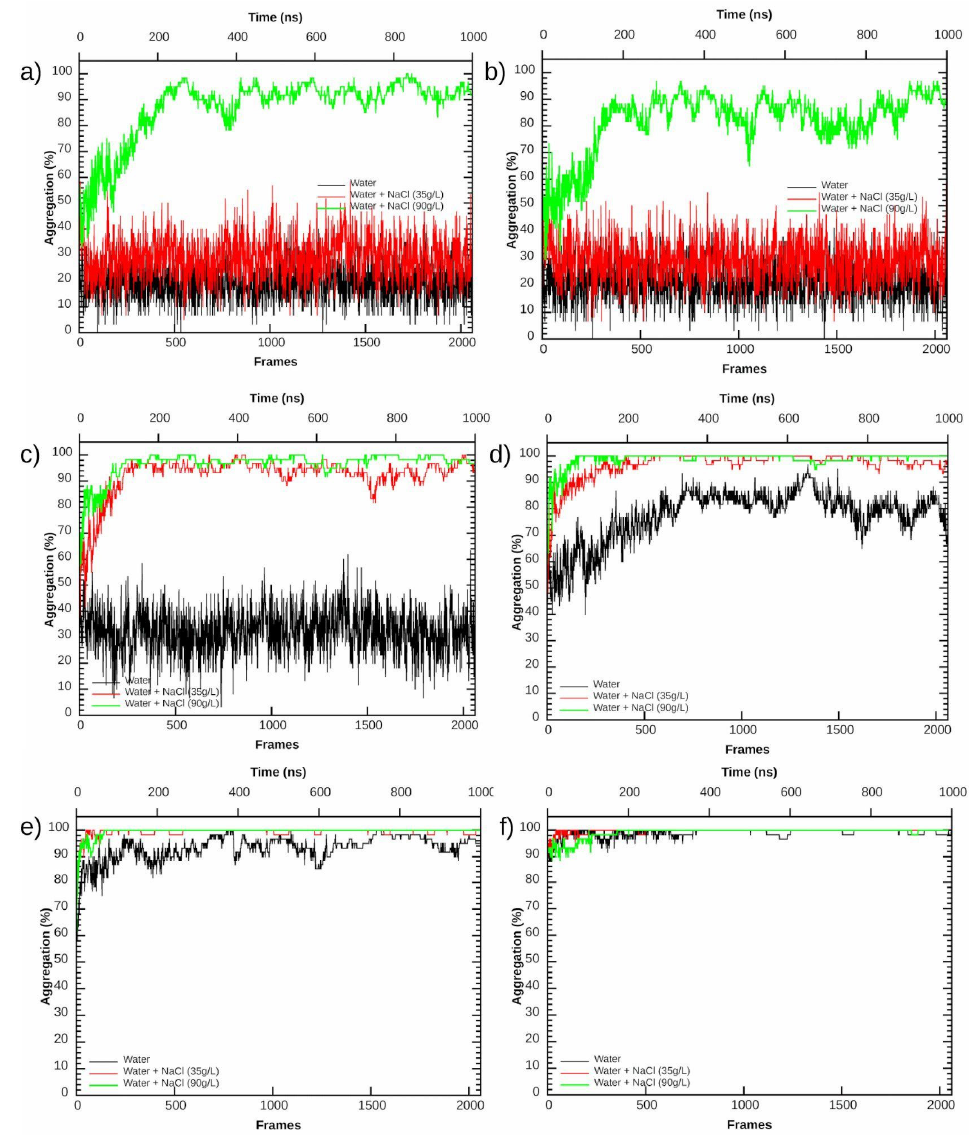
Figure 3. Percentage of aggregation along MD trajectories for different NAs in pure water (black), in low salinity solution (NaCl 35 g/L—red), and in high salinity solution (NaCl 90 g/L—green): ( a ) c9, ( b ) c10 aromatic, ( c ) c10, ( d ) c11, ( e ) c12 and ( f )